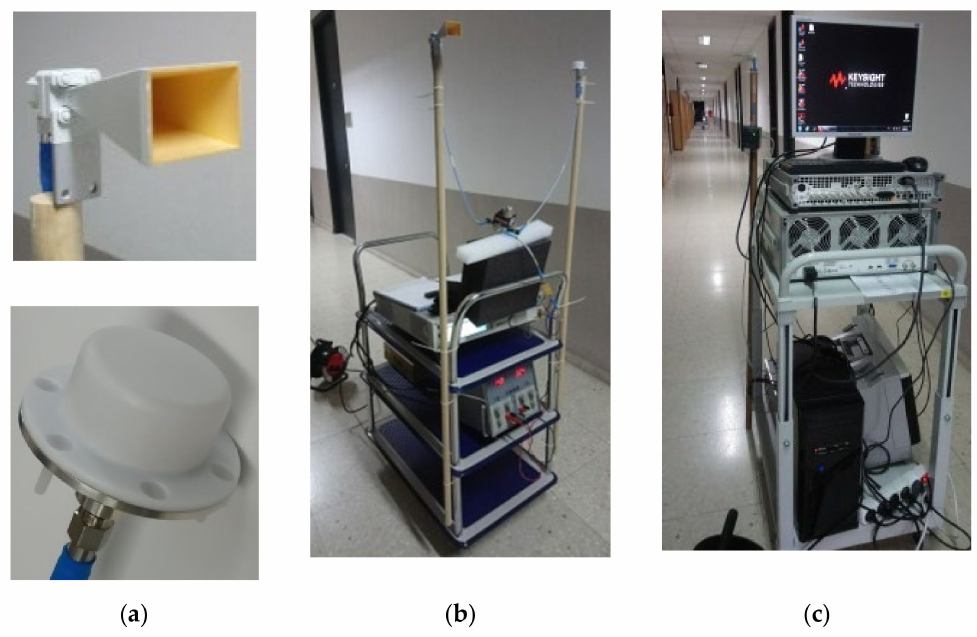
Figure 2. Main setup components: ( a ) horn (top) and omnidirectional (bottom) antennas; ( b ) transmitter unit; and ( c ) receiver